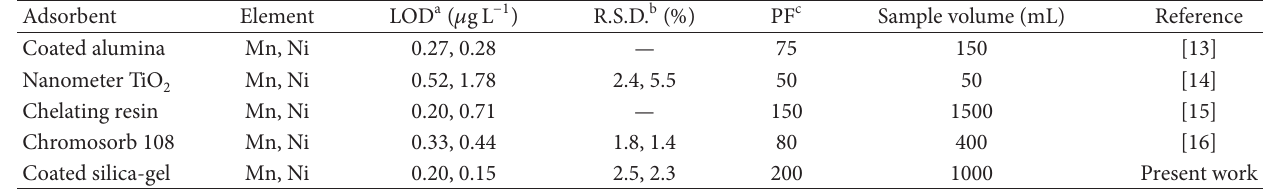
T 5: Comparison of the proposed SPE method with other SPE methods reported in the literature. Adsorbent